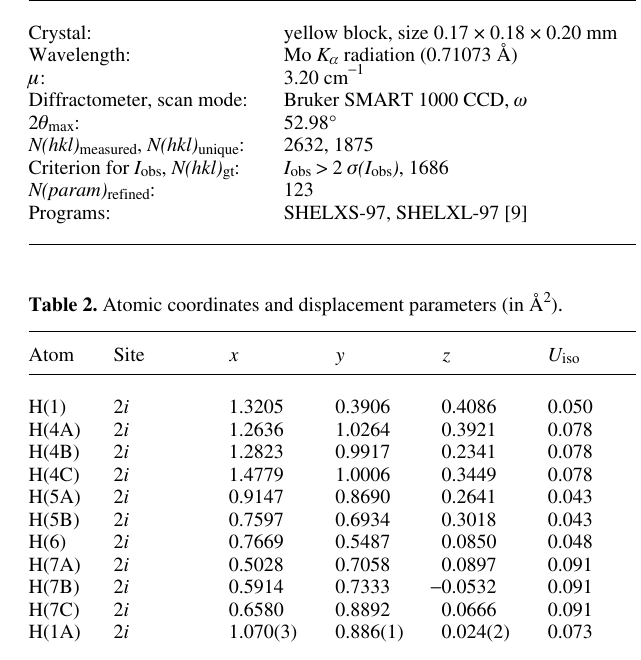
Table 1. Data collection and handling.